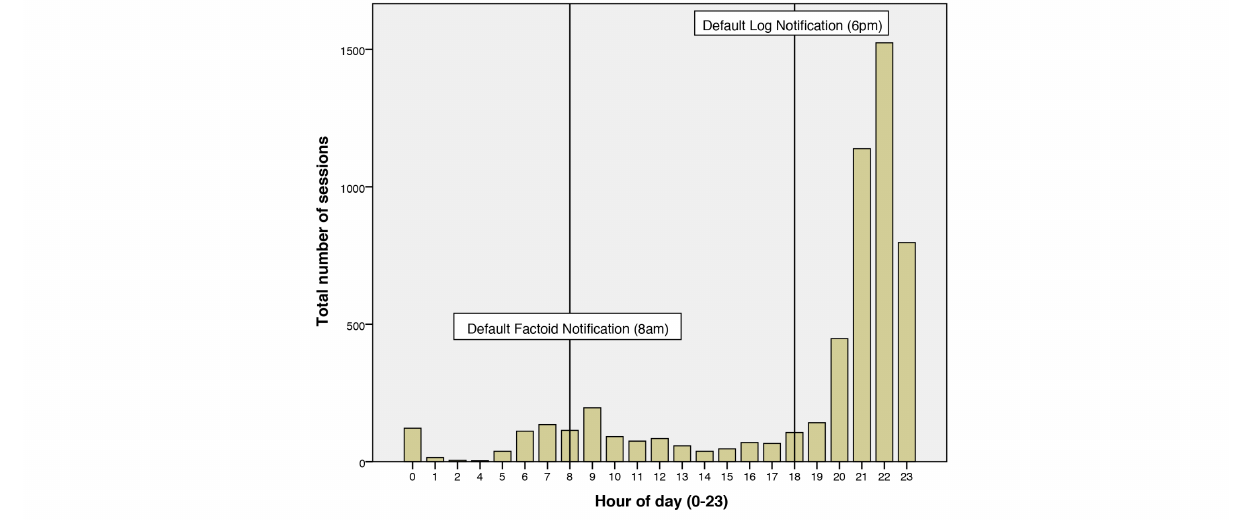
Figure 7. Bar graph showing the typical hours of use, with morning activity around the default daily fact notification time at 8 AM and activity peaking at 10 PM, 4 hours after the default log notification time.